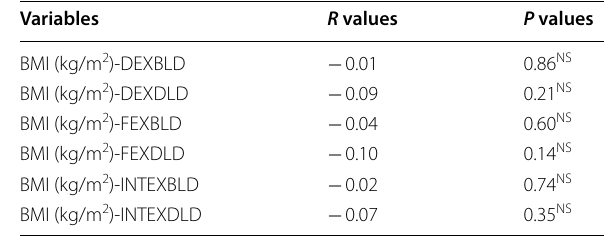
Table 2 Relationship between Body Mass Index, duration of exercise before and during lockdown, frequency of exercise before and during, and intensity of exercise before and during COVID-19